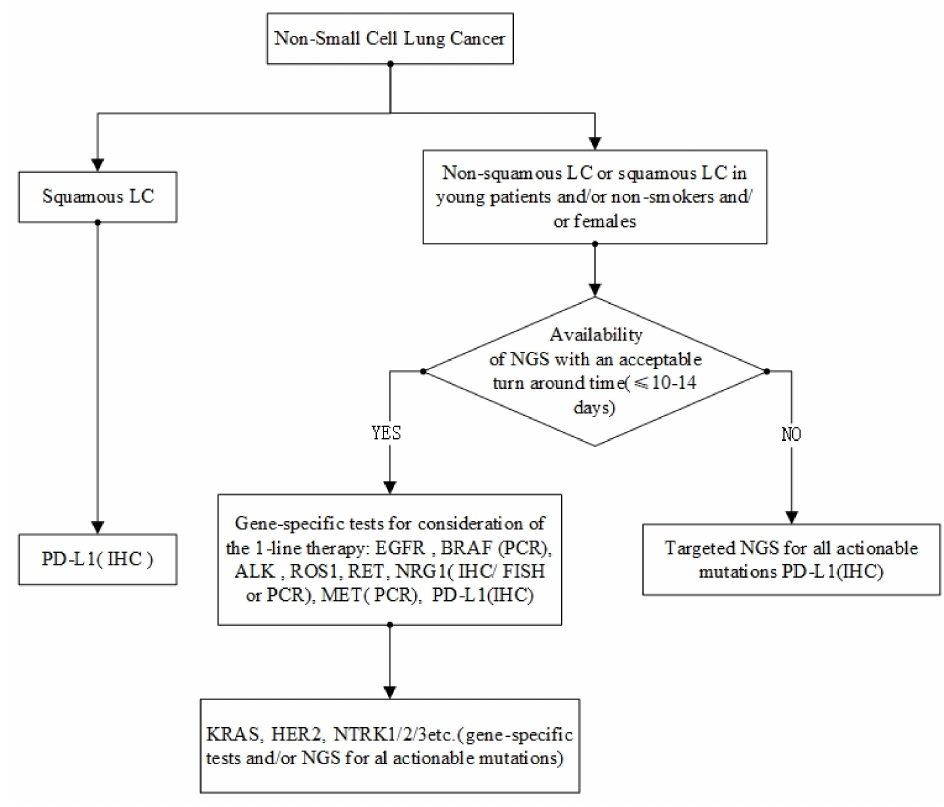
Figure 3. Current molecular tests for oncogenic